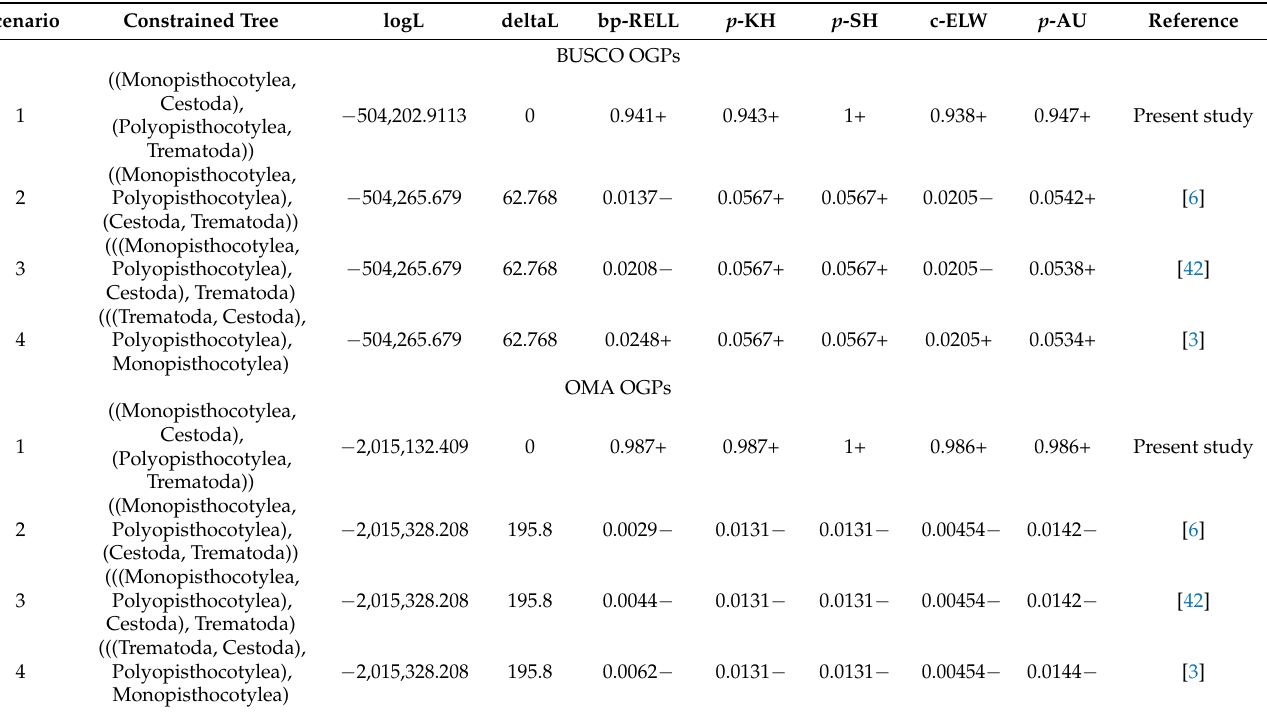
Table 1. Tree topological test for four evolutionary scenarios of neodermatans, based on OGPs of two datasets (BUSCO and